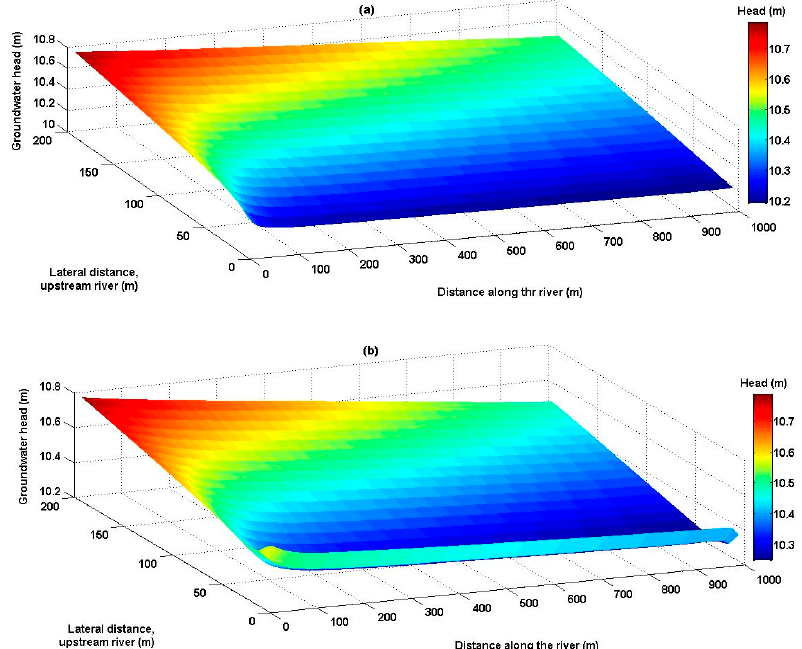
Figure 12. Groundwater head obtained from STRIVE for the Aa River based on the hydrodynamic river boundary with a transient simulation: ( a ) at the beginning of the pulse (24 h), and ( b ) at the maximum effect of the pulse (32 h).